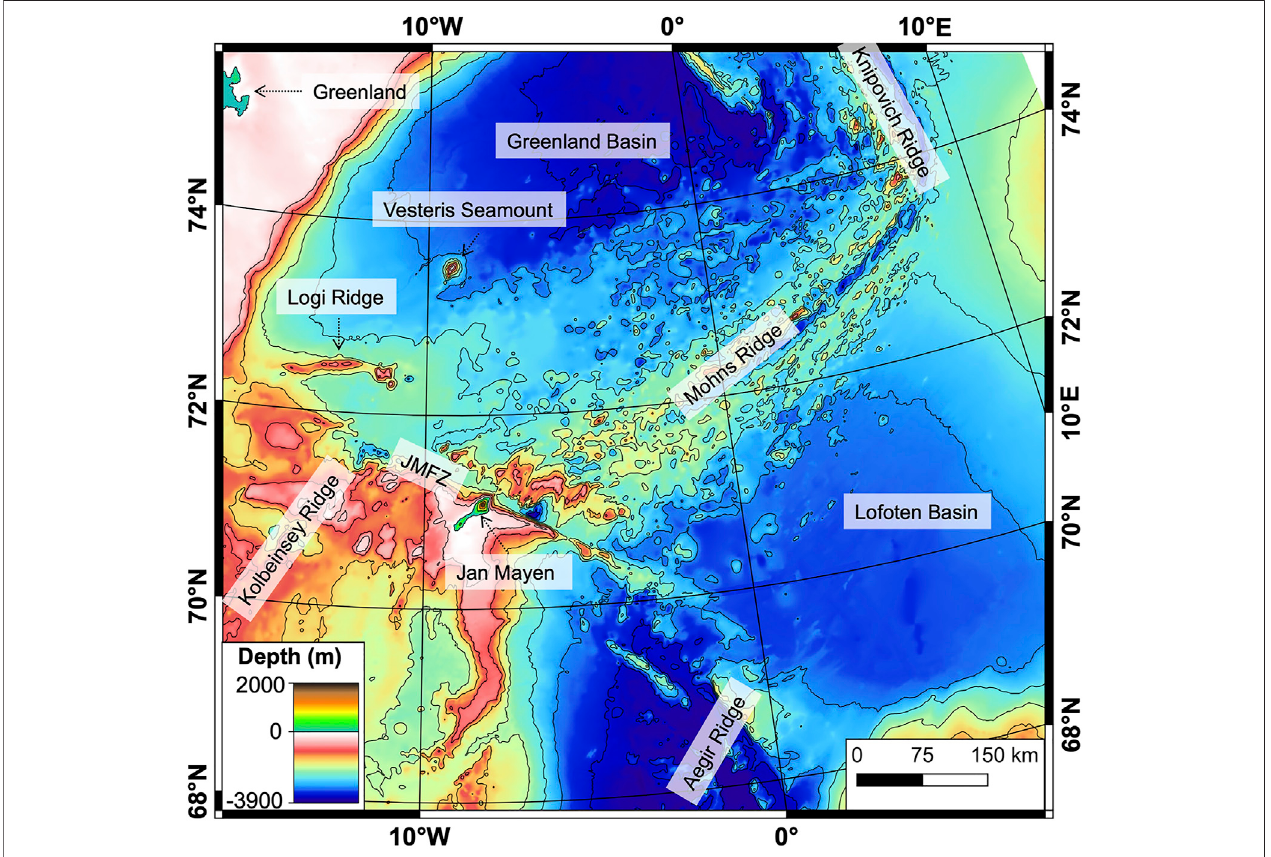
FIGURE 1 | Bathymetric map of the North Atlantic between 67 and 74.5 ° N showing the location of the Vesteris Seamount. The contours are 500 m elevation. All scales in the fi gures are linear.